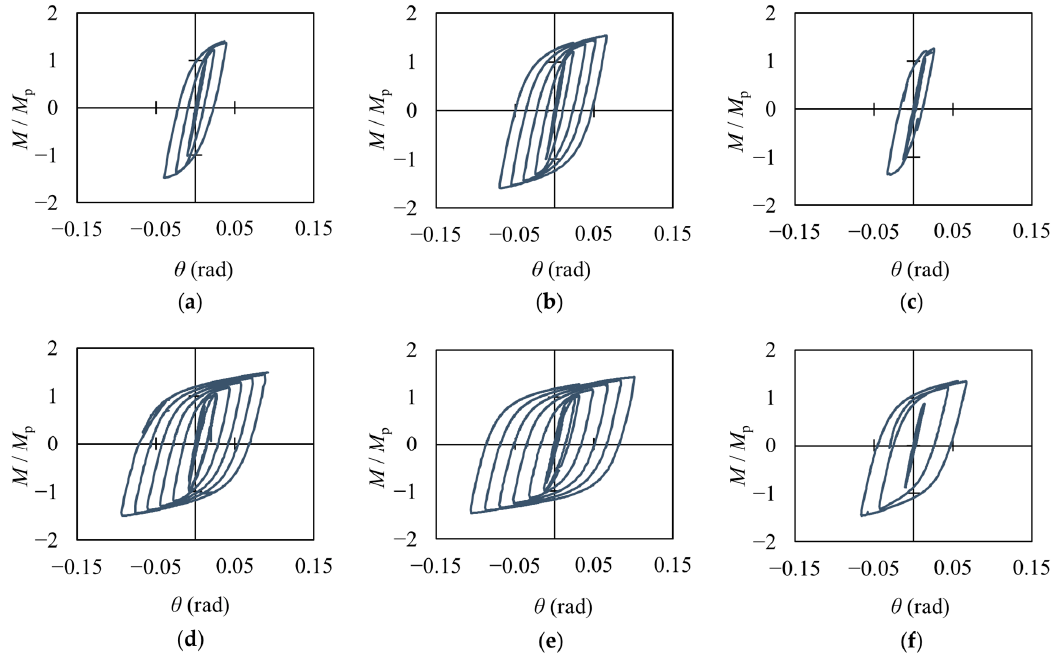
Figure 8. Hysteresis loops of the specimens: ( a ) FTC-8C, ( b ) FSC-7C, ( c ) FSC-14C, ( d ) DTC-8W, ( e ) DTC-12W, and ( f ) DSC- 21W. The vertical axes of the loops are non-dimensionalized by dividing their values by M p . ( a – c ): Reprinted with permission from Ref. [15]. Copyright 2016 Springer Nature.